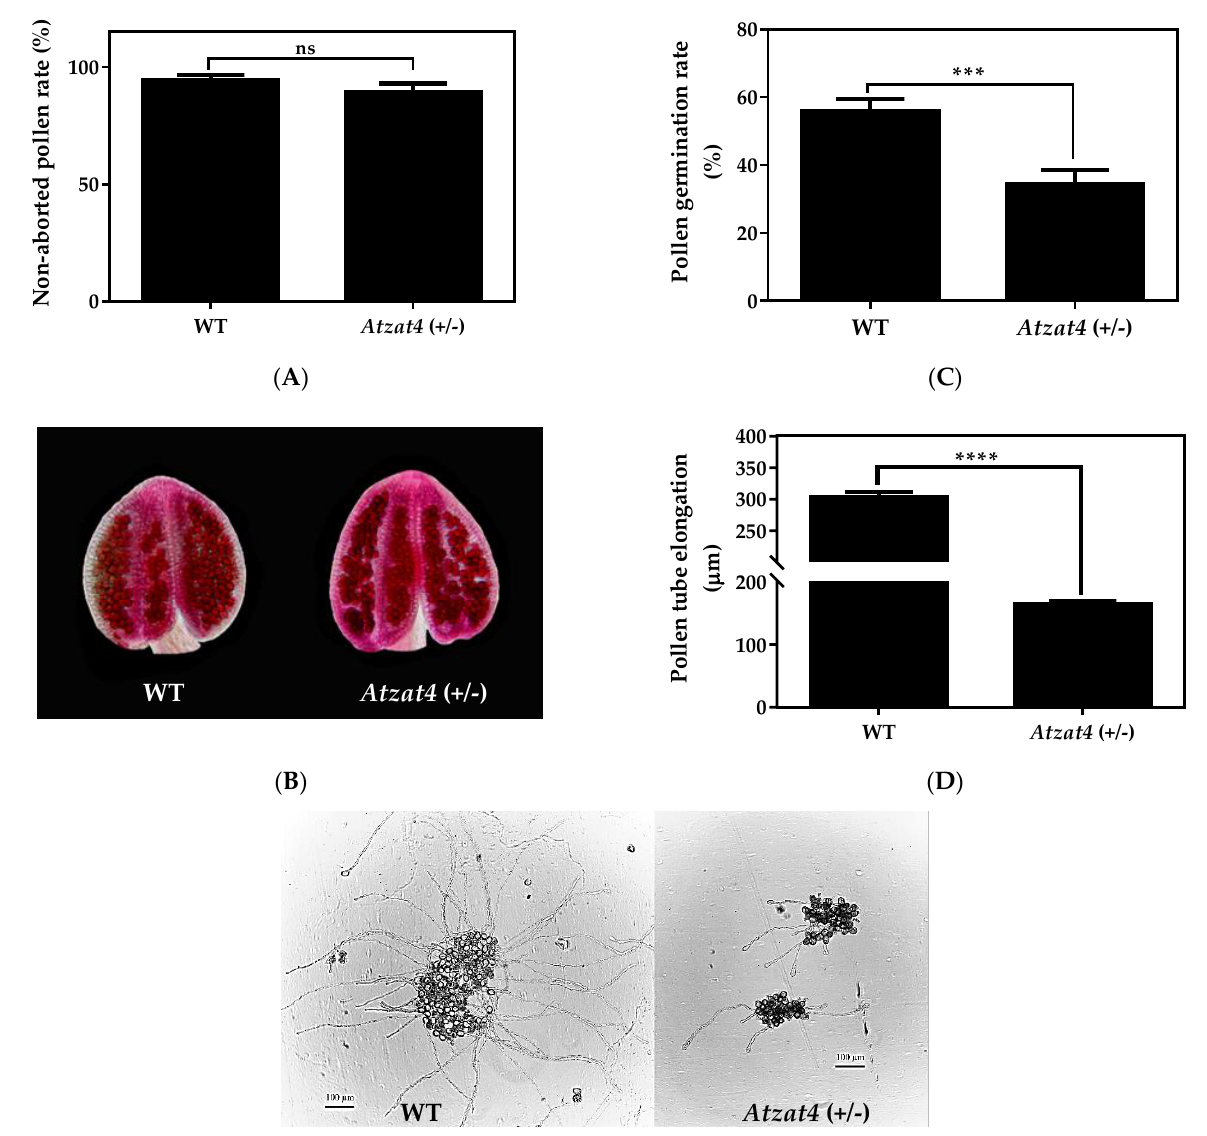
Figure 5. Male germline in Atzat4 (+/−) compared to WT in Arabidopsis thaliana . ( A , B ) Modified Alexander stain [34]. ( A ) Non-aborted pollen grain quantification. ( B ) . Alexander red staining of pollen grains by anther, non-aborted pollen grains are stained red. ( C – E ) In vitro pollen grain germination and pollen tube elongation . ( C ) Quantification of germinated pollen grains ( n = 300 pollen grains analyzed). ( D ) Pollen tube elongation quantification ( n = 300 pollen grains germinated). ( E ) In vitro pollen grain germination and pollen tube elongation under the light microscope. In ( A , C , D ) data correspond to the mean ± SE; **** p < 0.0001, *** p < 0.001, ns: not significant. In ( B , E ), bars = 100 µ m. For details, see Section